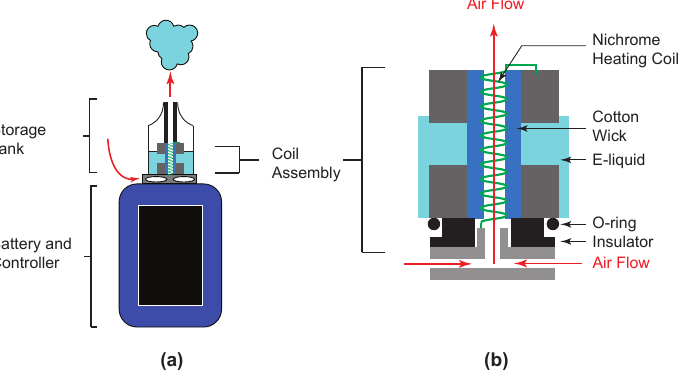
Figure 1. Schematic diagram of Vaporesso Revenger Mini E-cigarette used in this study. ( a ) General assembly with storage tank, coil assembly, and battery. ( b ) Magnified view of the coil assembly. For clarity, the assembly shown here has only one coil, while the GT8 coil assembly used in this study had four nichrome heating coils that heated simultaneously. Airflow through the device is indicated by red